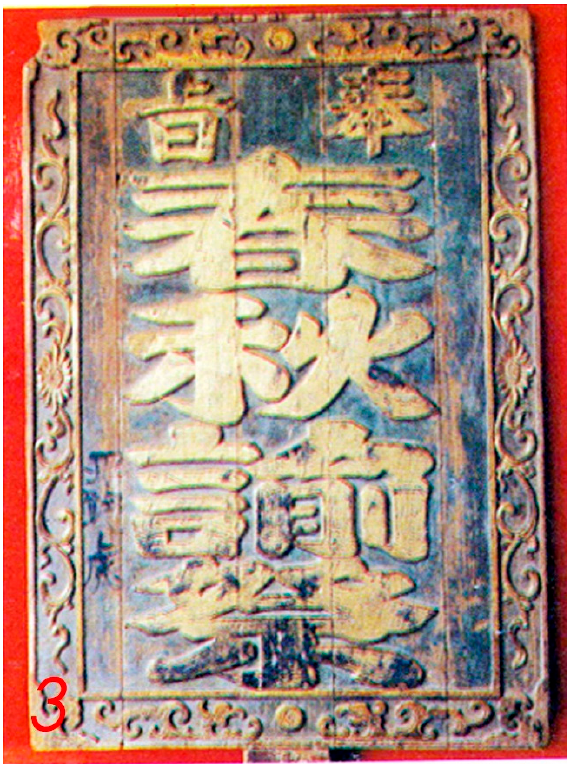
Figure 3. The Wooden Plate, “Performing Official Sacrifices in Spring and Autumn Ordered by Imperial Edict.” Preserved in The Ancestral Hall of the Celestial Empress at Xianliang Port. Source: Provided by the Temple management board of Xianliang gang zuci.